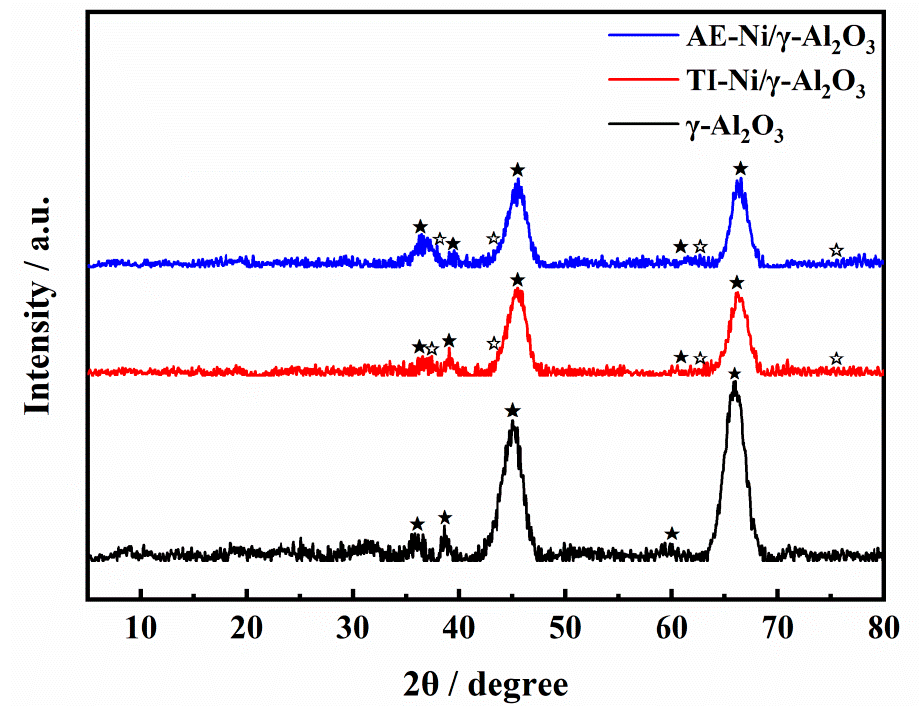
Figure 2. PXRD pattens of γ -Al 2 O 3 , TI-Ni/ γ -Al 2 O 3 , AE-Ni/ γ -Al 2 O 3 ( ☆ NiO , ★ γ -Al 2 O 3 ).